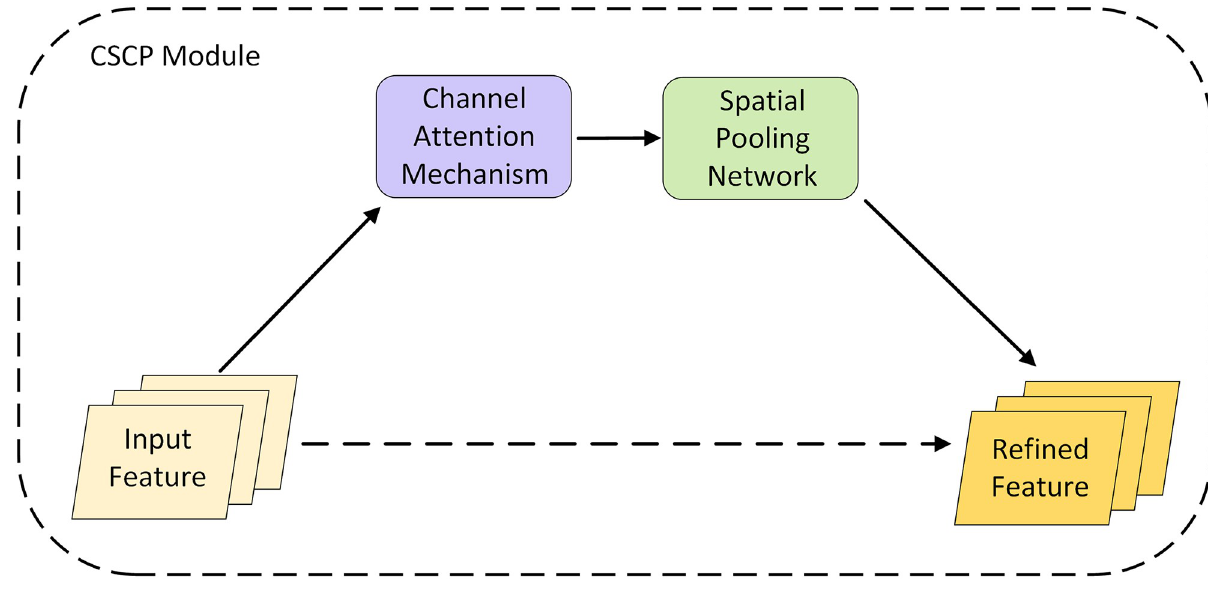
Fig 2. The channel and spatial combined processing (CSCP) module.